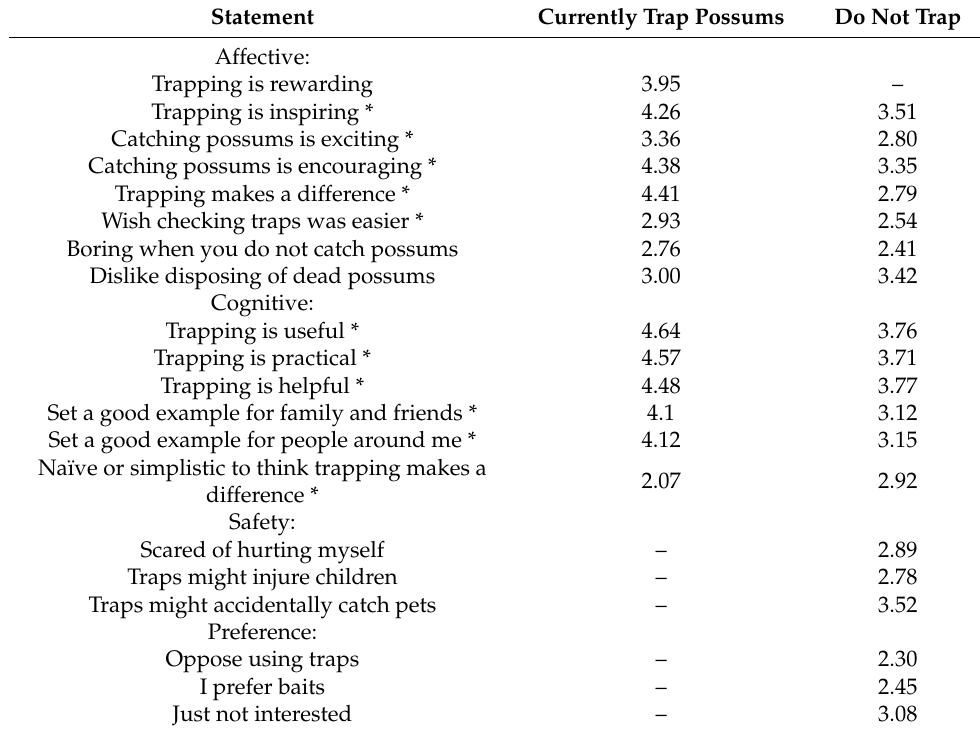
Table 10. Real and imagined experience with